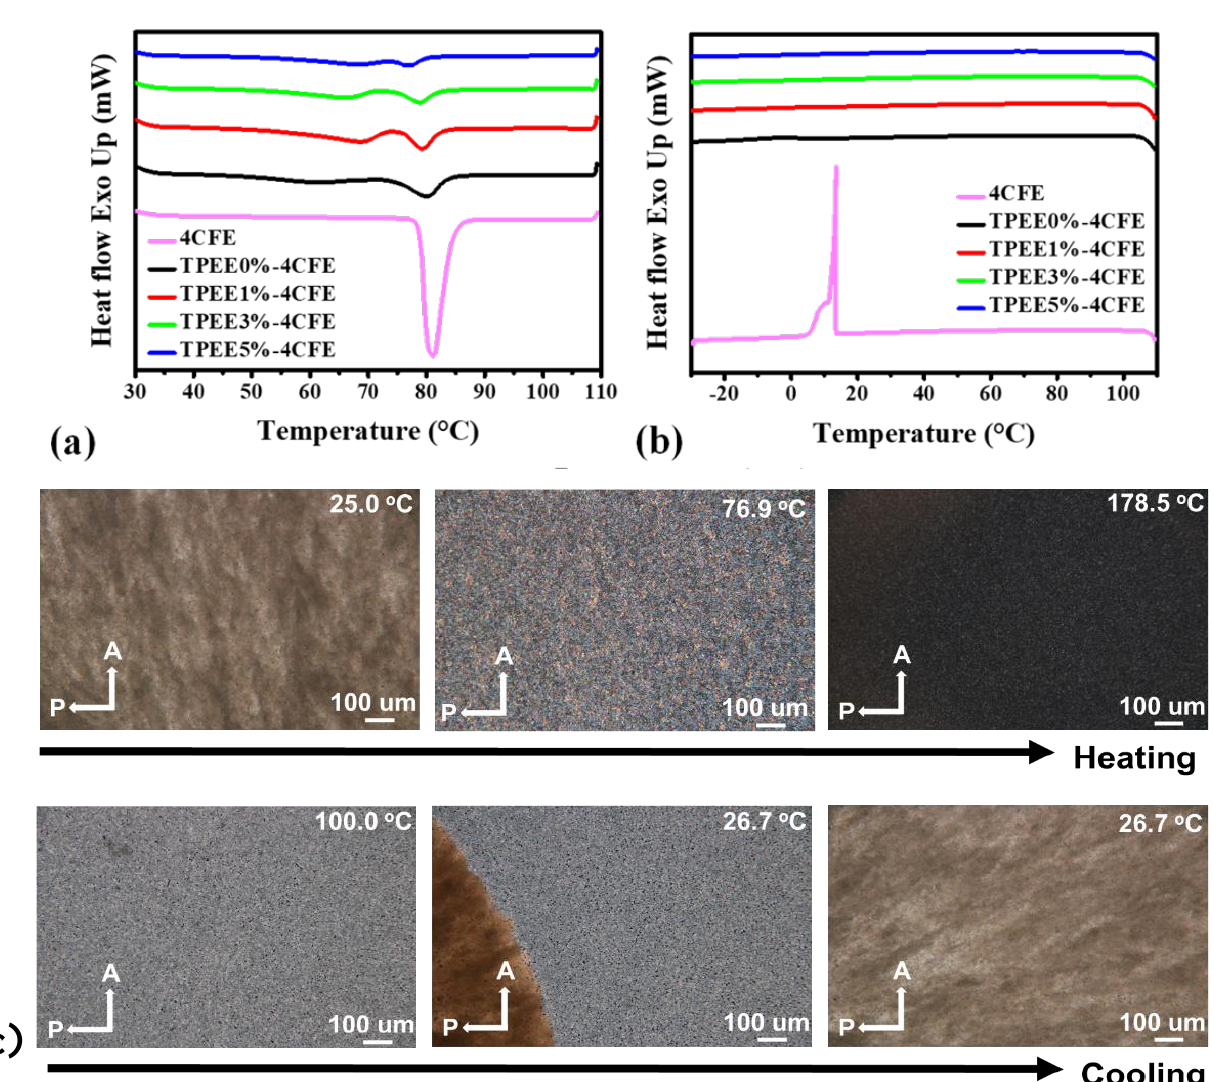
Figure 3. Thermal characterization of 4CFE and TPEEn%-4CFE and the POM texture of TPEE3%-4CFE. ( a ) DSC first-heating thermograms, ( b ) DSC first-cooling thermograms, and ( c ) the mesophase of TPEE3%-4CFE from 100 to 25 °C with analysis for POM (bright parts are 4CFE and black parts are TPEEn%). Table 1. DSC data of 4CFE and TPEEn%-4CFE.